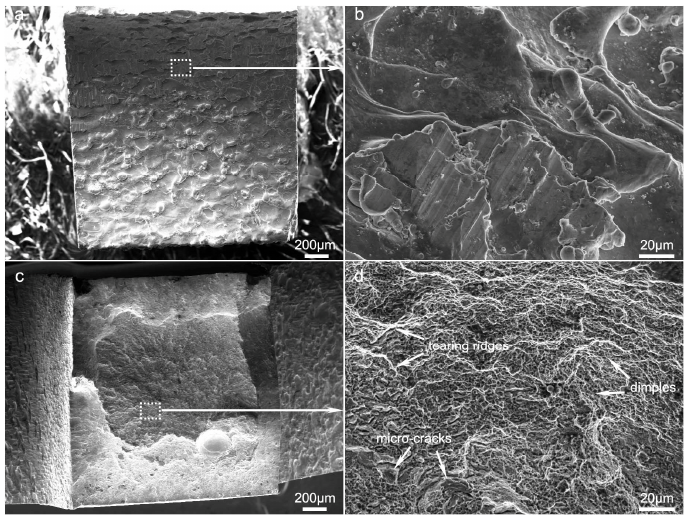
Figure 7. Fractography of tensile specimens at different magnifications: ( a , b ) as-cladded specimen; ( c , d ) as-tempered specimen.